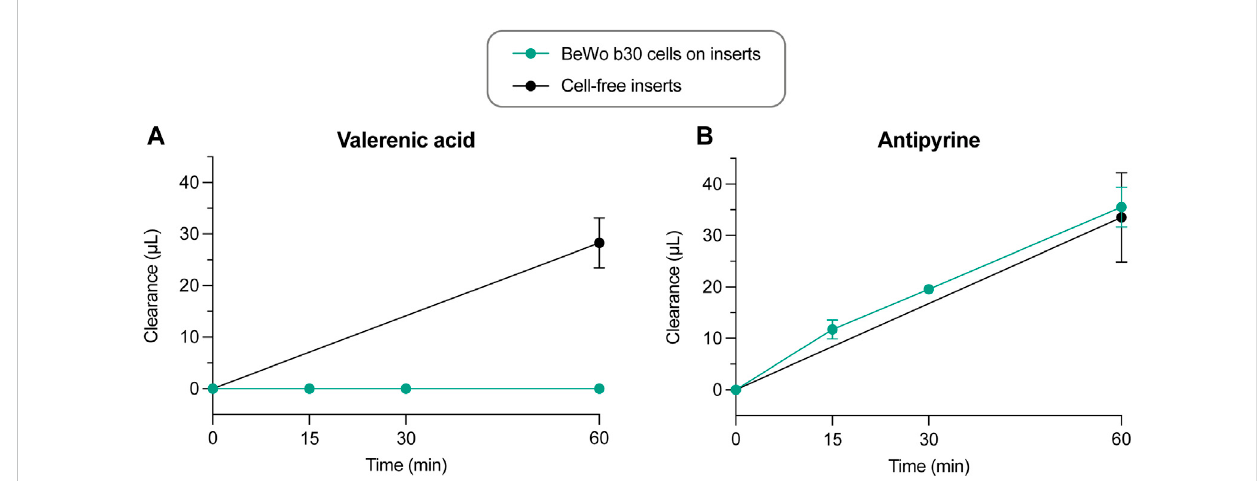
FIGURE 8 Clearancevs.timecurvesofcontrolexperimentsacrosscell-freeinserts(n=4)andacrossBeWob30celllayersforvalerenicacidandantipyrine(n= 3 – 6). Data are presented as mean ±